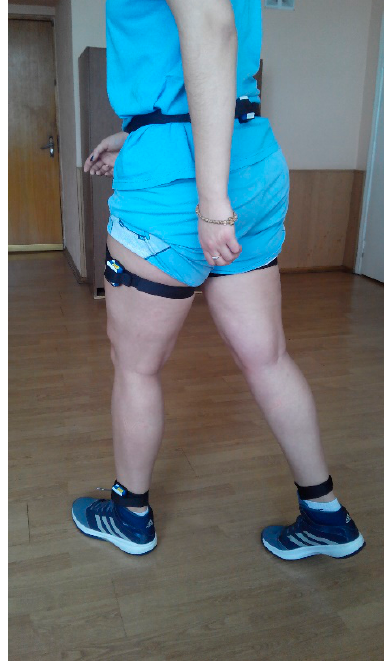
Figure 1. Placement of the sensors.